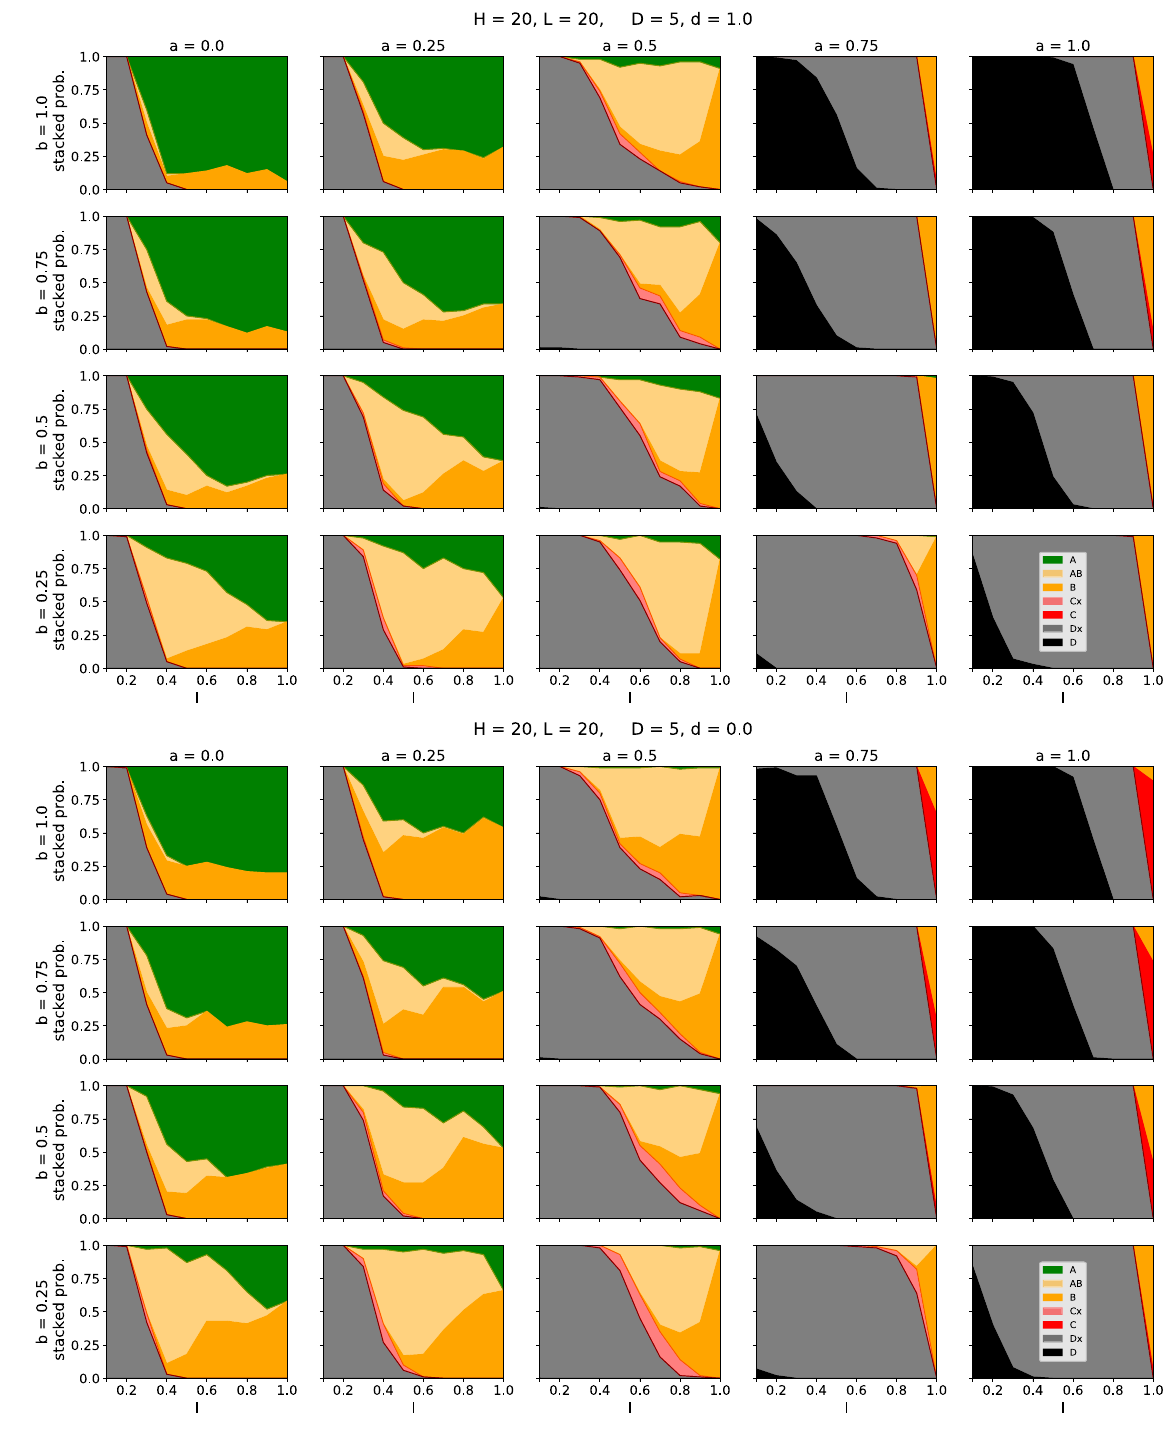
Figure 4. Dependence of the observed cases on the fraction of active inputs I . For the upper figure, the clustering parameter was set to d = 1 which means that all defective nodes form one cluster. Contrarily, in the lower figure, the parameter was set to d = 0 , leading to a broad distribution of the defective nodes. For each parameter combination, the system was simulated 100 times for 1000 time steps. The colour code (as defined in Fig. 1a) indicates, which cases occurred in the time line. Here, Cx and Dx denote that the time line also contained the cases (A, B) or (A, B, C), respectively. Curves for other sets of parameters are provided in the